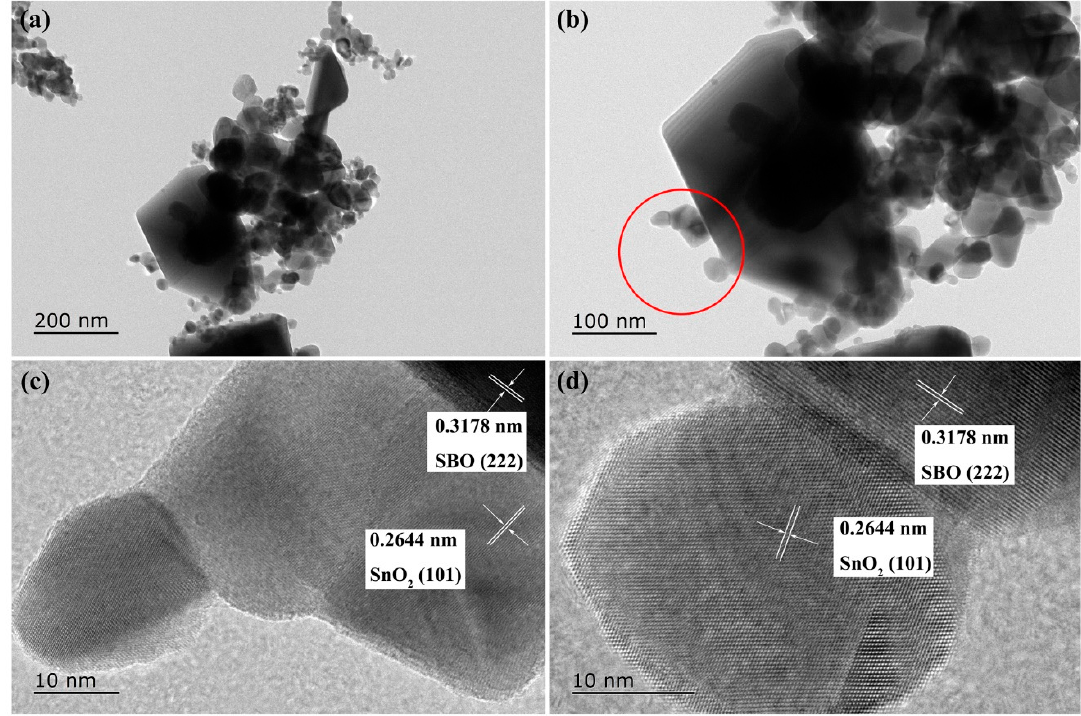
Figure 4. Transmission Electron Microscope ( a , b ) and High Resolution Transmission Electron Microscope ( c , d ) images of 14 wt% SBO/SnO 2 composite.